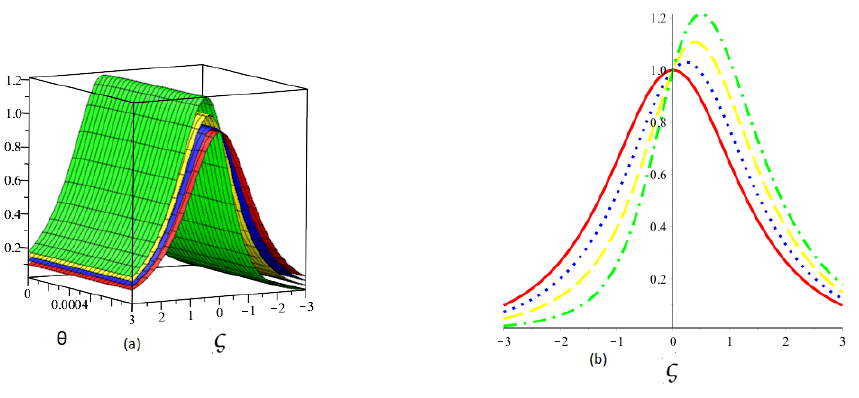
Figure 3. The obtained solution is graphically depicted for various order of ℘ in ( a ) three dimensions and ( b ) two dimensions.